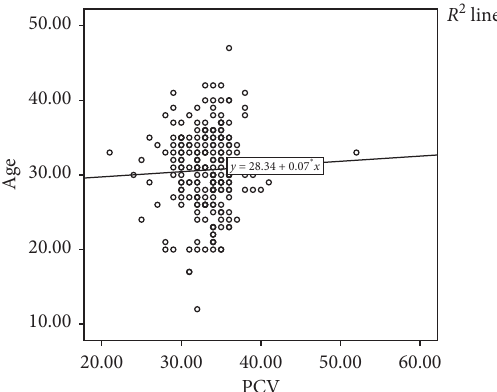
Figure 4: Correlation between maternal age and